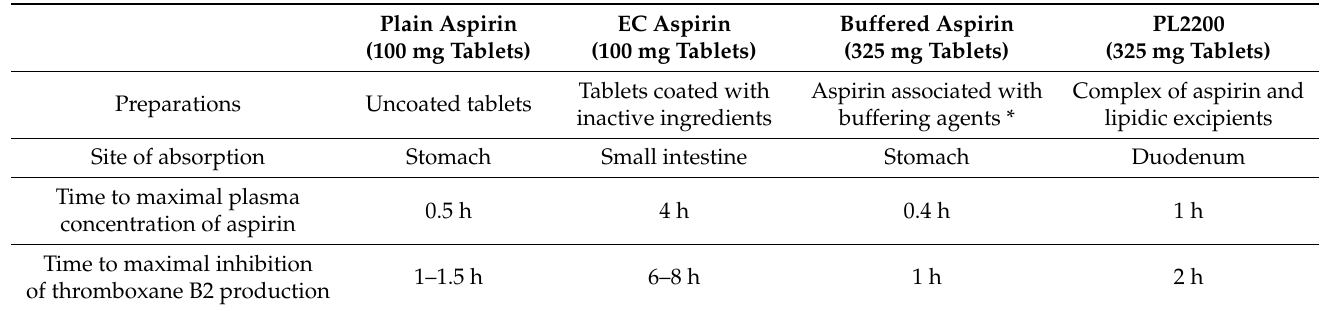
Table 1. Pharmacokinetics and pharmacodynamics of plain aspirin, enteric-coated aspirin, buffered aspirin, and PL2200 after oral administration to healthy